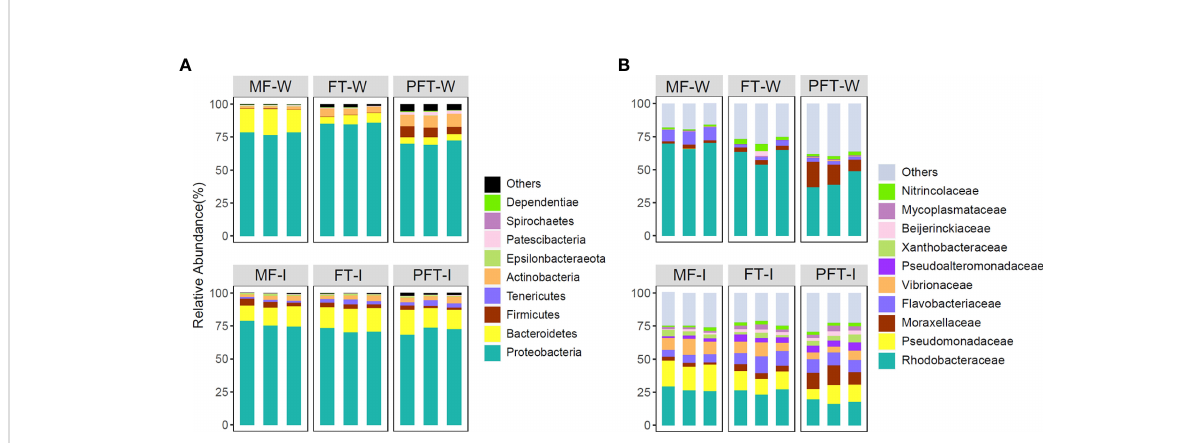
FIGURE 7 Bacterial composition of different communities. (A) bacterial community bar plot at the phylum level with the relative abundance (top 10); (B) bacterial community bar plot at the family level with the relative abundance (top